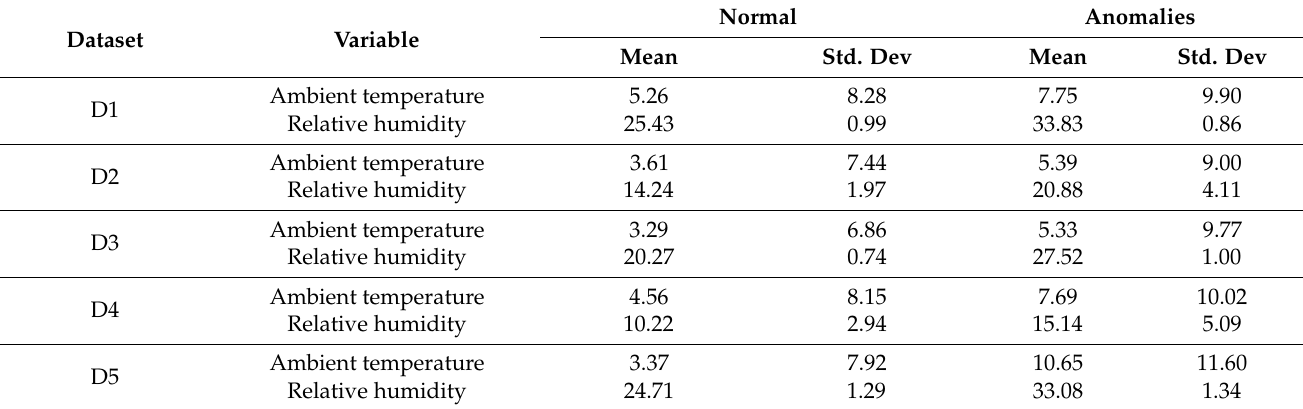
Table 1. Statistical characteristics for normal and generated artificial anomalies for GSB datasets.